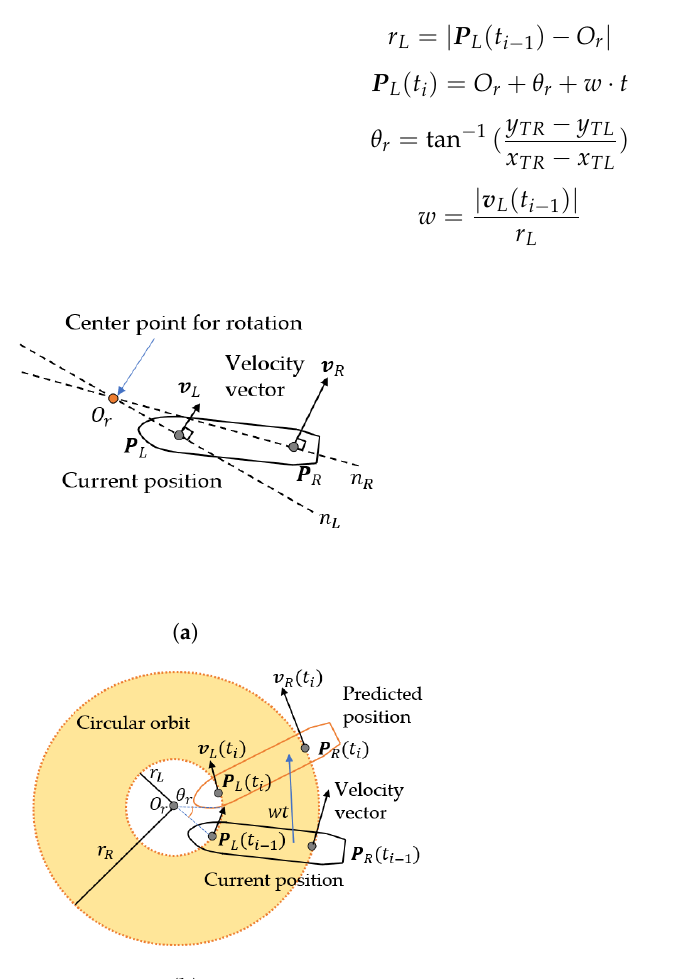
Figure 6. Vessel positioning predicted with a curve motion: ( a ) calculation of the center point to rotate a vessel; ( b ) predicted circular